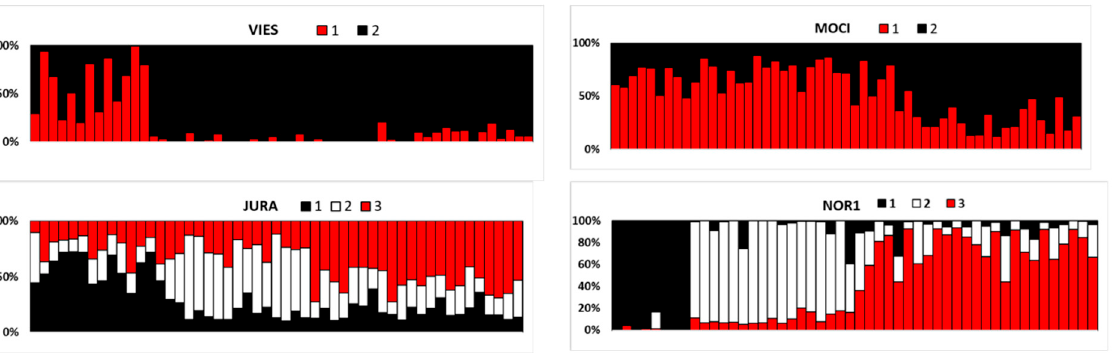
Figure 3. Individual tree assignment scores to the within stand STRUCTURE genetic groups based on Bayesian clustering of the trees with each in stand analyzed separately. Colors mark the genetic groups, defined in the legend. Please explain the colors in the figure.